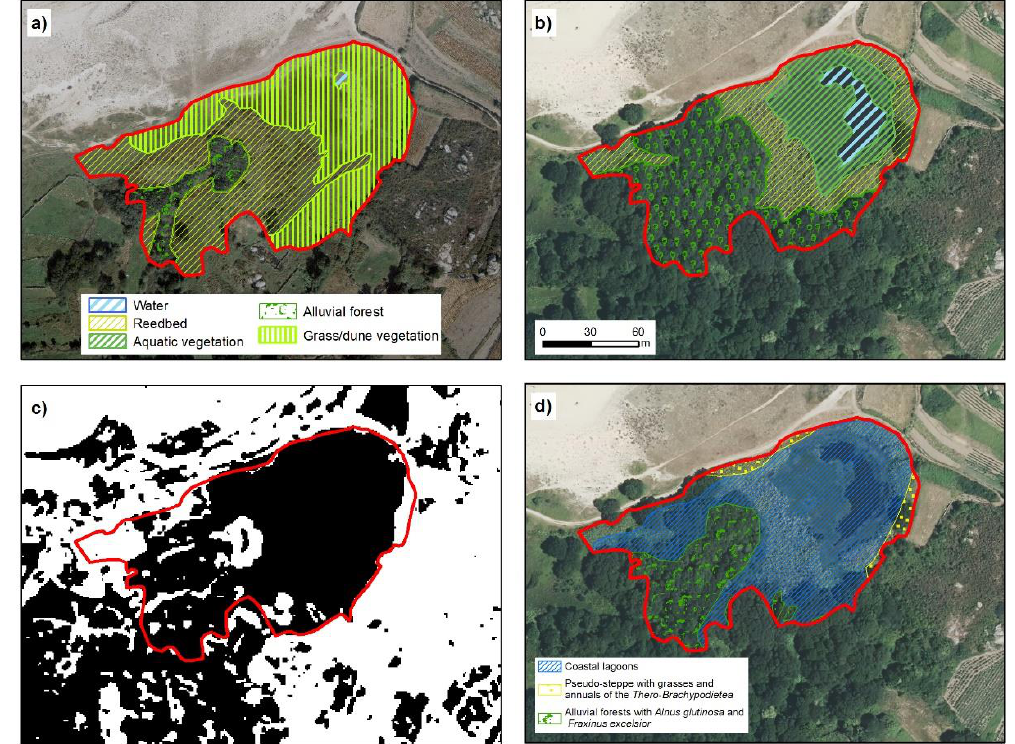
Figure 8. Lake of Bodeira. ( a , b ) represent the temporal evolution of environmental units in 1989 and 2017, respectively. ( c ) shows TRI classification, in black, values below mean and in white the values above mean. ( d ) Official cartography representing the distribution of habitats from Annex I of Habitats Directive. The red line in all cases represent the extent marked for the lagoon by our analysis (IGN, [20]; Xunta de Galicia © ).